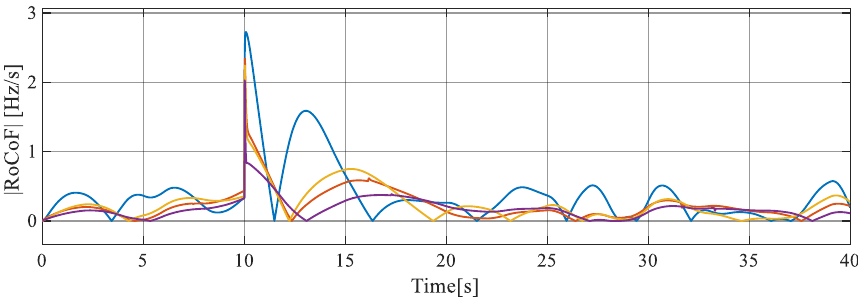
Figure 18. Dynamics of RoCoF during a sub-frequency contingence under actual wind speed con- ditions.